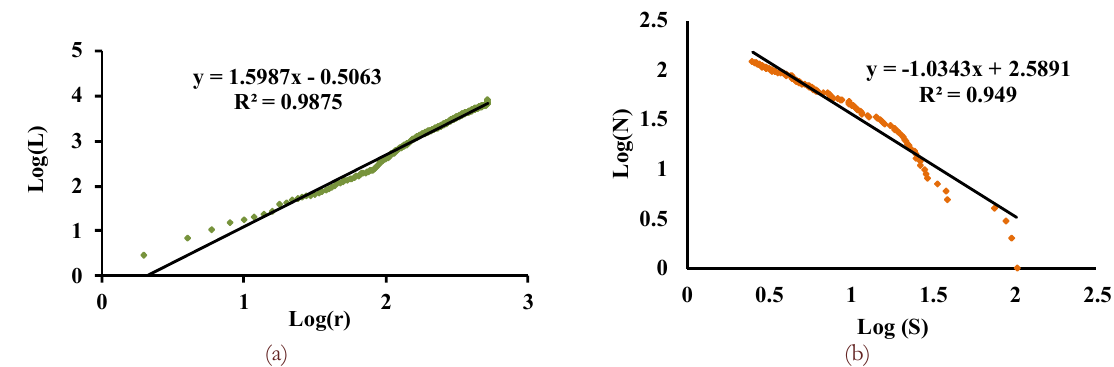
Figure 2: a) Scaling law obtained using the relation for crack length (1). b) Cumulative distribution of the fragment size in a log-log plot.